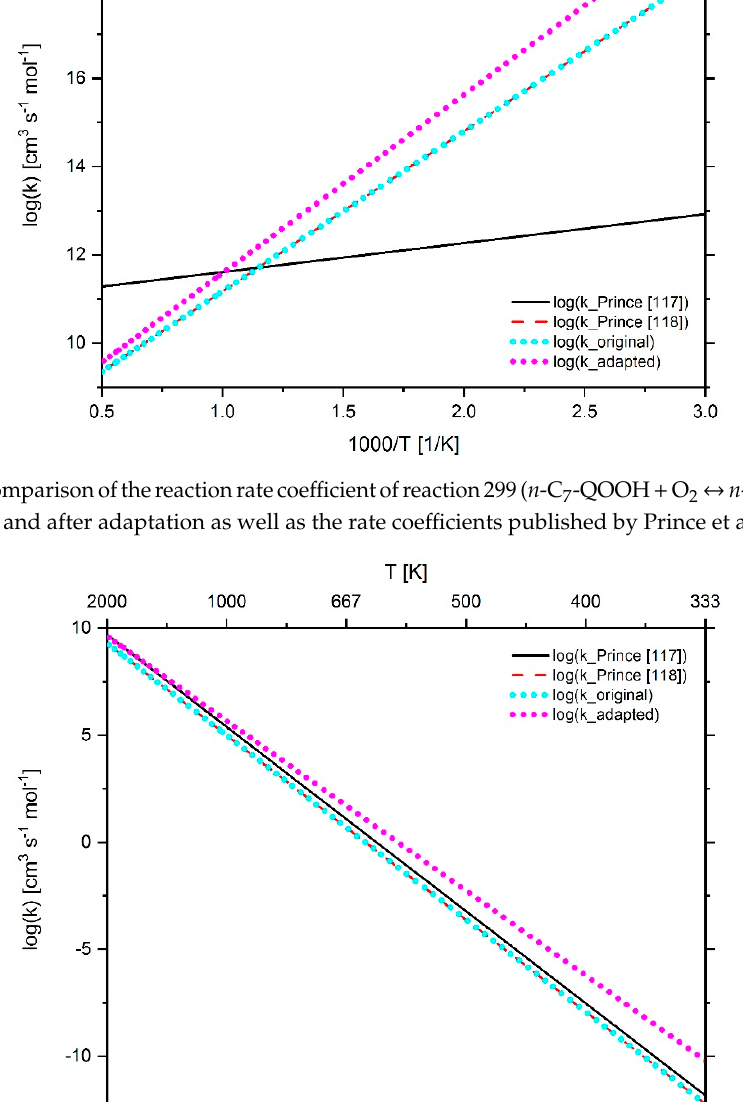
ffi cients published by